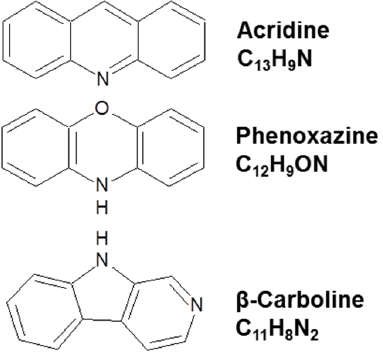
Figure 8. Comparing MAC bulk (m 2 g − 1 ) for organic solvent ex- tractable material from brushwood– chulha (blue) and dung– chulha (red) samples. Shaded regions represent errors due to extraction ef- ficiency and sampling flow